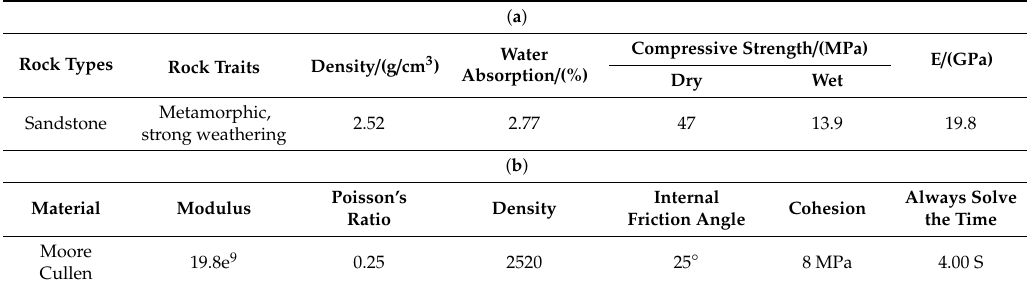
Table 1. Rock sample property parameter setting table.